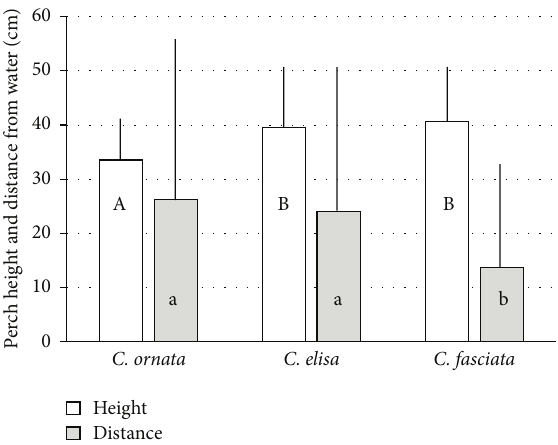
Figure 2: Mean (+ SD) perch height and distance from open water (cm) for perches used by male Celithemis ornata ( 𝑁 = 278 ), C. elisa ( 𝑁 = 331 ), and C. fasciata ( 𝑁 = 207 ) at Ashmore Heritage Preserve, Greenville County, SC, USA, from May to July 2015. For each variable, species labeled with the same letter are not significantly different (Tukey mean comparison tests, 𝑃 = 0.05